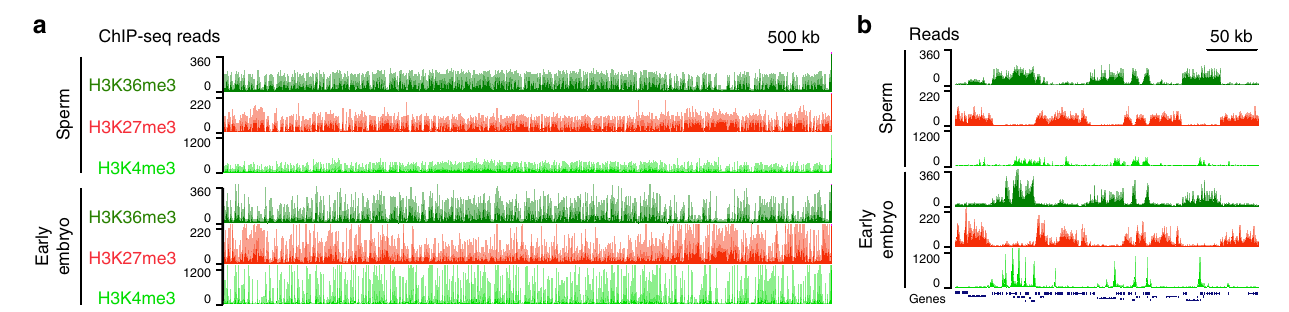
Fig. 1 C. elegans sperm retain modi fi ed histones across the genome, and H3K36me3 and H3K27me3 generally occupy mutually exclusive domains. a Genome-browser view of H3K36me3 (green), H3K27me3 (red), and H3K4me3 (lime) ChIP-seq from sperm and early embryos across chromosome I. The y-axis shows normalized ChIP-seq read counts. b Zoomed-in genome-browser view, showing the generally mutually exclusive occupancy of H3K36me3 and H3K27me3 in sperm and early embryos over ~ 40 genes. The entire genome is shown in Supplementary Fig. 2c. Figs 1 – 3 and Supplementary Fig. 5 show 1 replicate. Another biological replicate, shown in Supplementary Fig. 4, demonstrates the consistency of